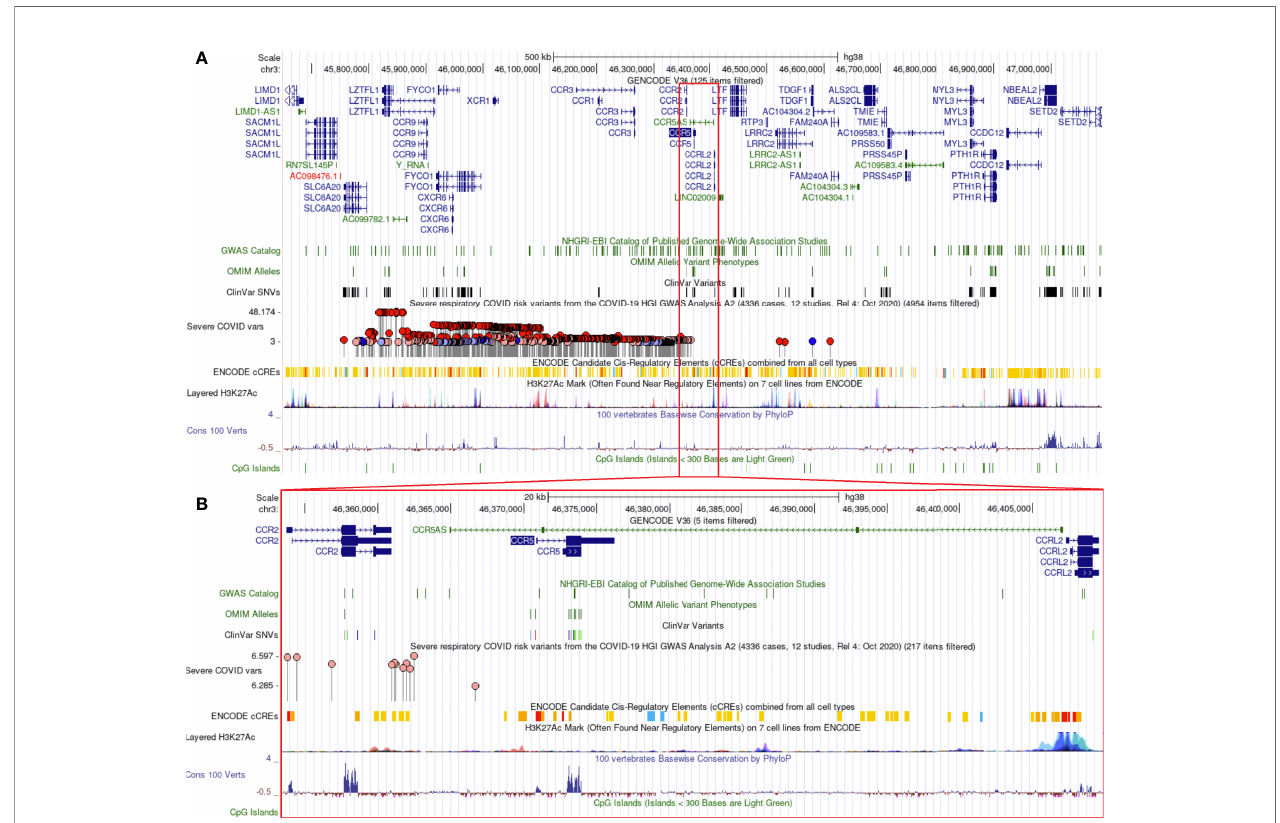
FIGURE 3 | Genomic architecture around CCR5. The genome browser view (hg38) of around one million bases near CCR5 (A) or zoomed into around 40,000 bases (B) . Tracks shown include the Gencode transcripts, known variants from GWAS/OMIM/ClinVar, the high-risk COVID-19 loci (higher dots are the strongest signal), various gene regulation insights (ENCODE cCTEs, H3K27Ac, CpG Islands), and evolutionary conservation (Cons 100